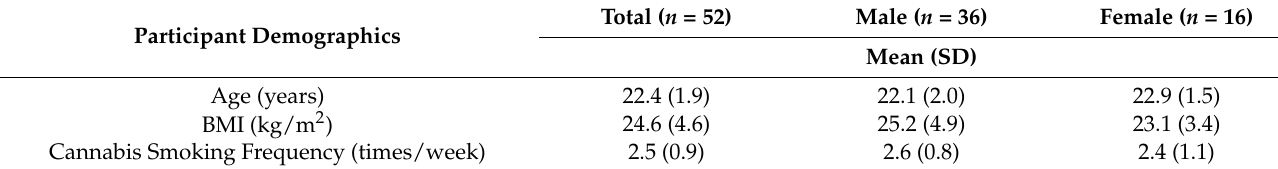
Table 1. Participant demographic data.